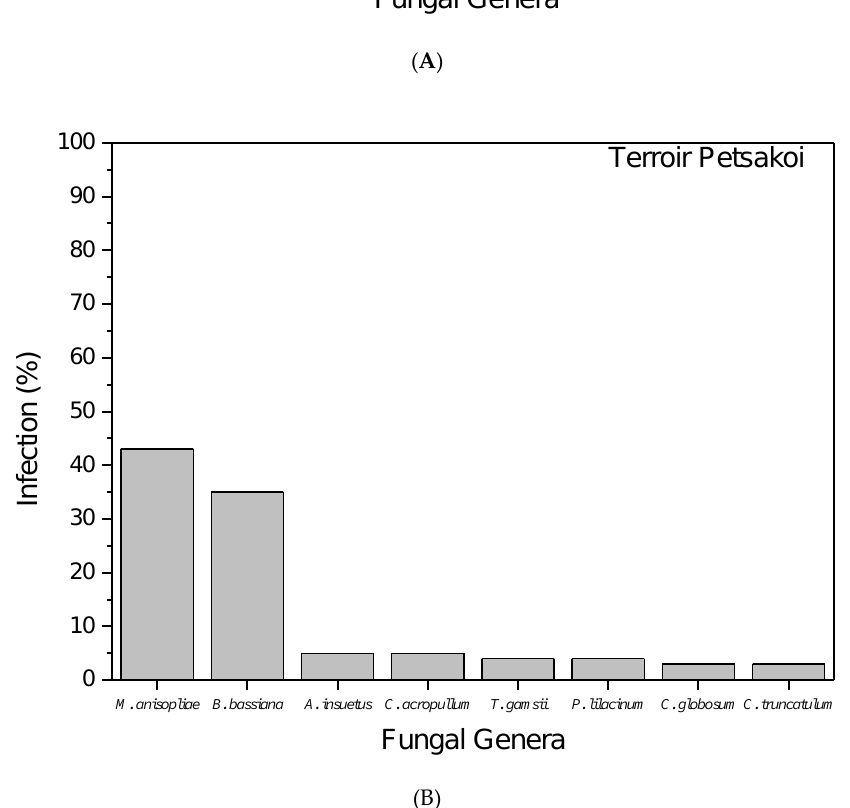
Figure 2. Frequency of entomopathogenic fungal species isolated from the vine terroir Koutsoura ( A ) and the vine terroir Petsakoi ( B ).